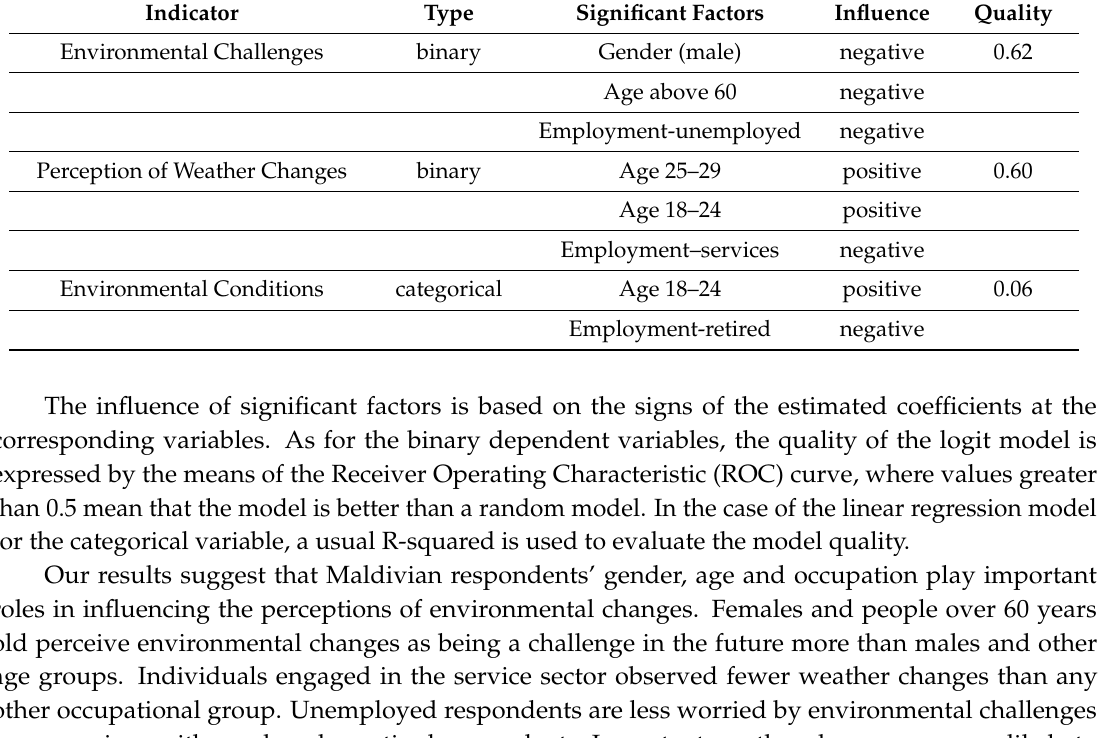
Table 7. Influence of socio-demographic factors on perceptions of environmental changes, Mal é .